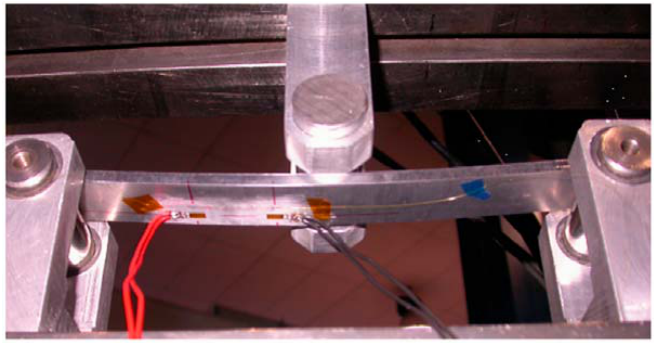
Figure 10. Photograph of the CFBG embedded in a load system for 3-point strain detection proposed by Bettini et al. Image from [57].